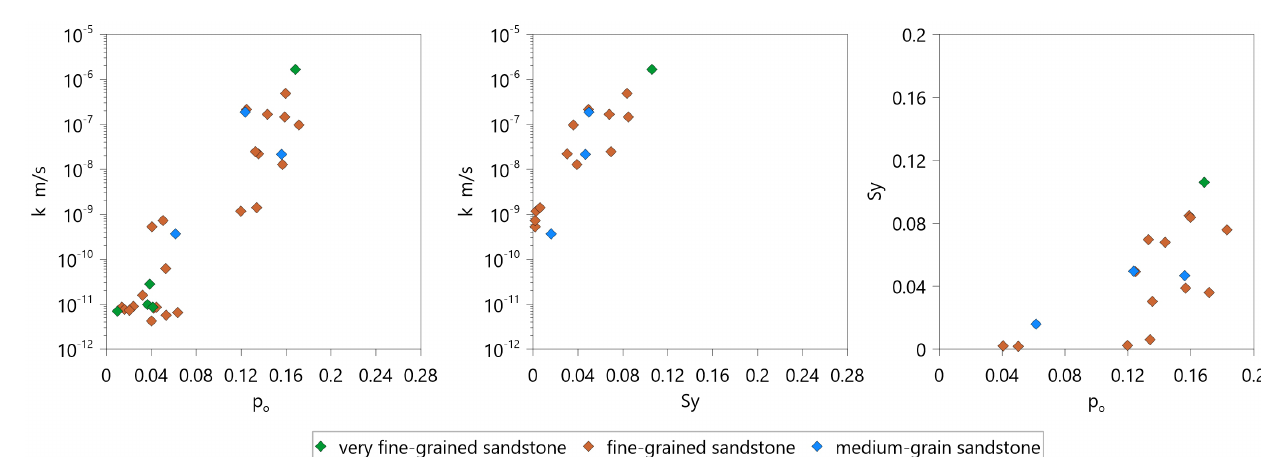
Figure 16. RQD vs. depth, p o and k in the sandstone.